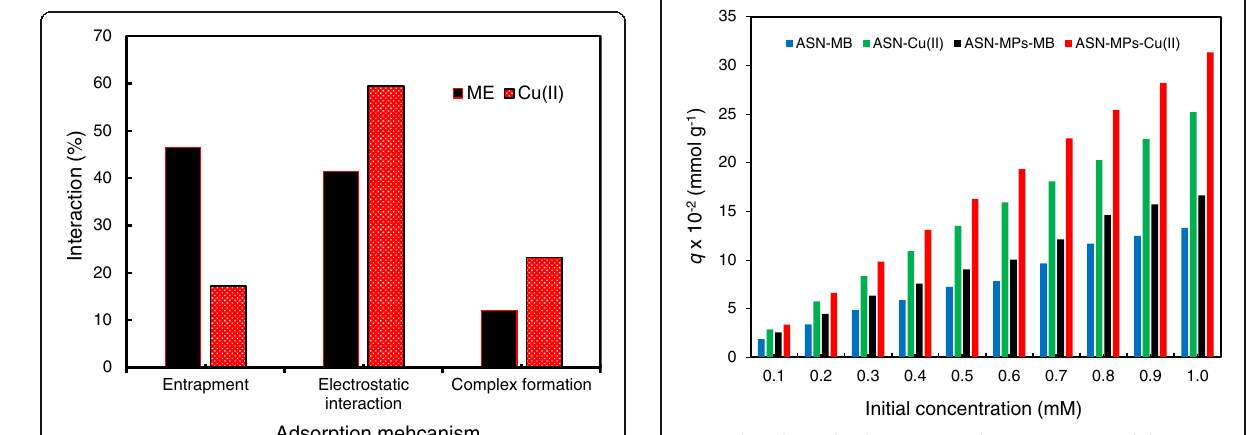
Fig. 9 The relationship between initial concentration and the amount of ME and Cu(II) cations adsorbed simultaneously on ASN and